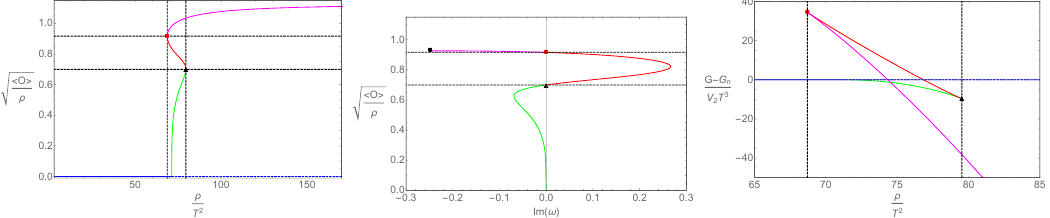
Figure 4 . A typical cave of wind phase transition. Left : the normalized scalar condensate as a function of the dimensionless charge density. Middle : the imaginary part of the amplitude mode of the superfluid phase. Right : the Gibbs free energy difference between the normal phase and the superfluid phase. All figures are for λ = − 0 . 8 , τ = 0 . 12 and m 2 = − 2 , q = 1 . The black triangle and the red square mark the two turning points. The black square denotes the position where the amplitude mode collide with another mode on the imaginary axes.